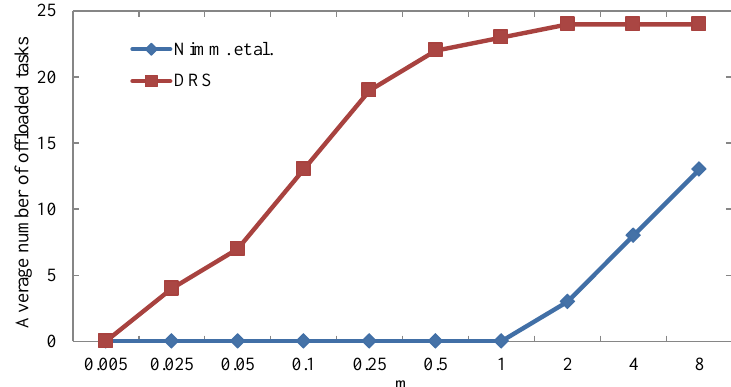
Figure 9 Number of offloaded tasks for synthesized tasks.